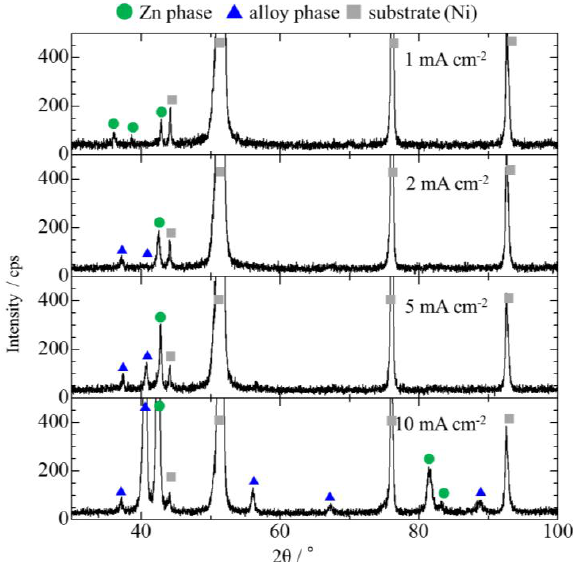
Figure 10. XRD patterns of the Zn–Fe–Mo platings deposited at various current densities.